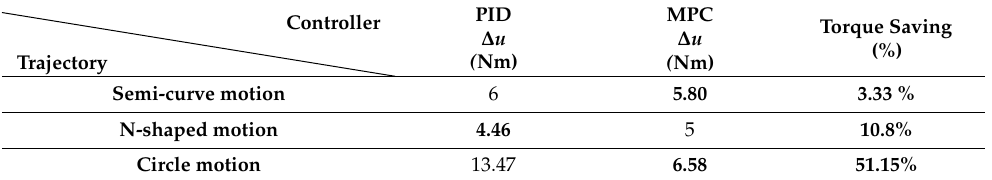
Table 9. The average torque parameter related to the three trajectories.